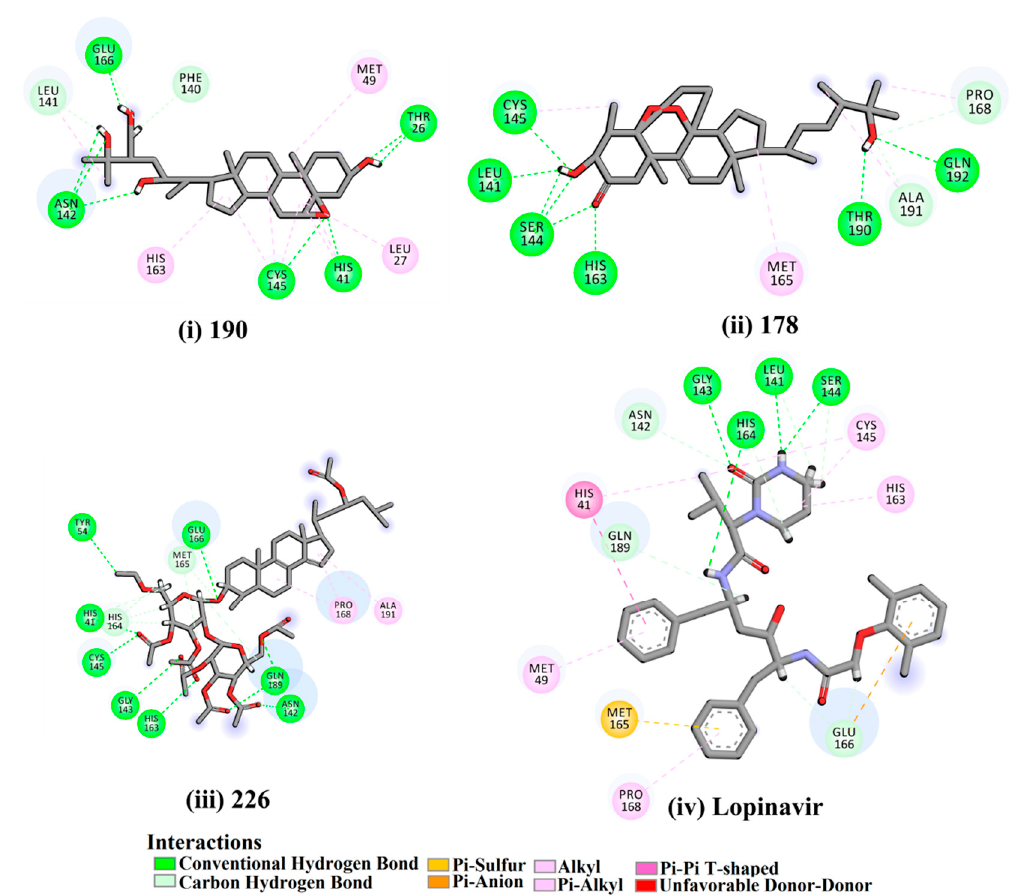
Figure 1. 2D representations of the predicted binding modes of MNPs ( i ) 190, ( ii ) 178, ( iii ) 226, and ( iv ) lopinavir towards SARS-CoV-2 main protease (M pro ).